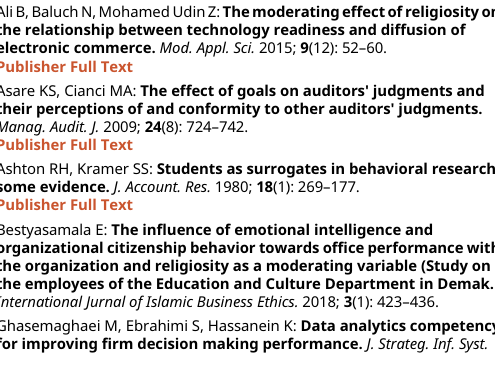
Figshare: Data Analytics Competency and Religiosity Influence on External Auditors ’ Performance in